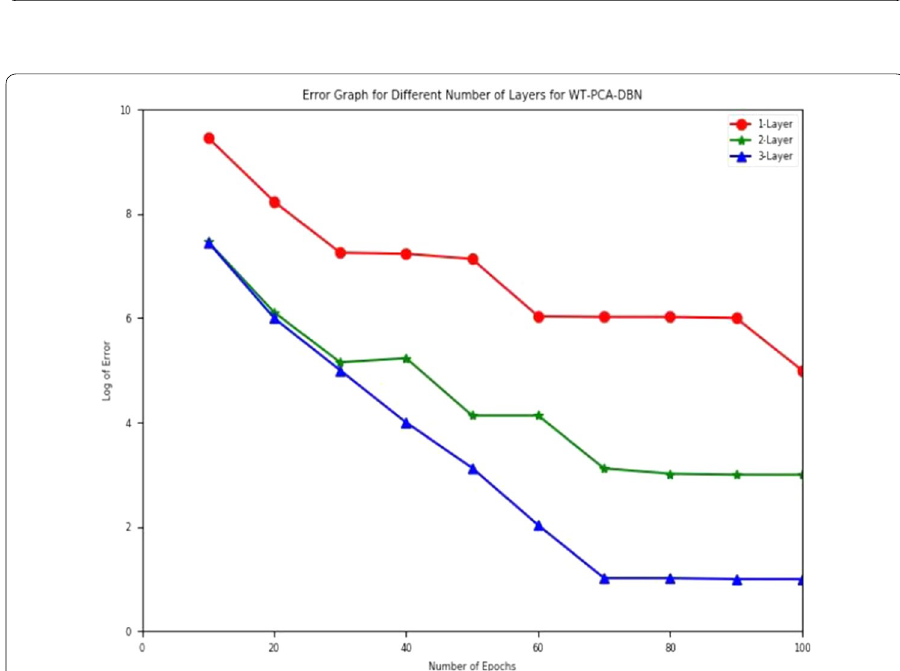
Fig. 6 Error graph for different number of layers for proposed